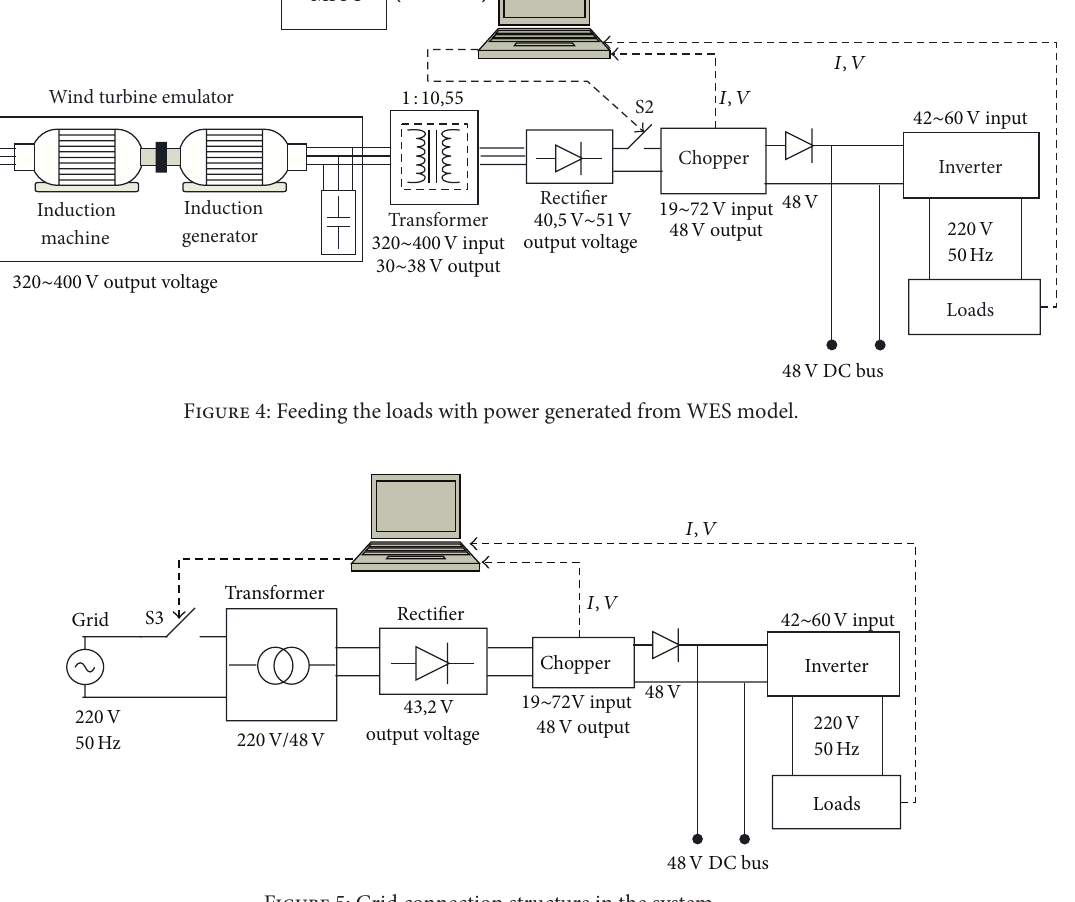
Figure 5: Grid connection structure in the